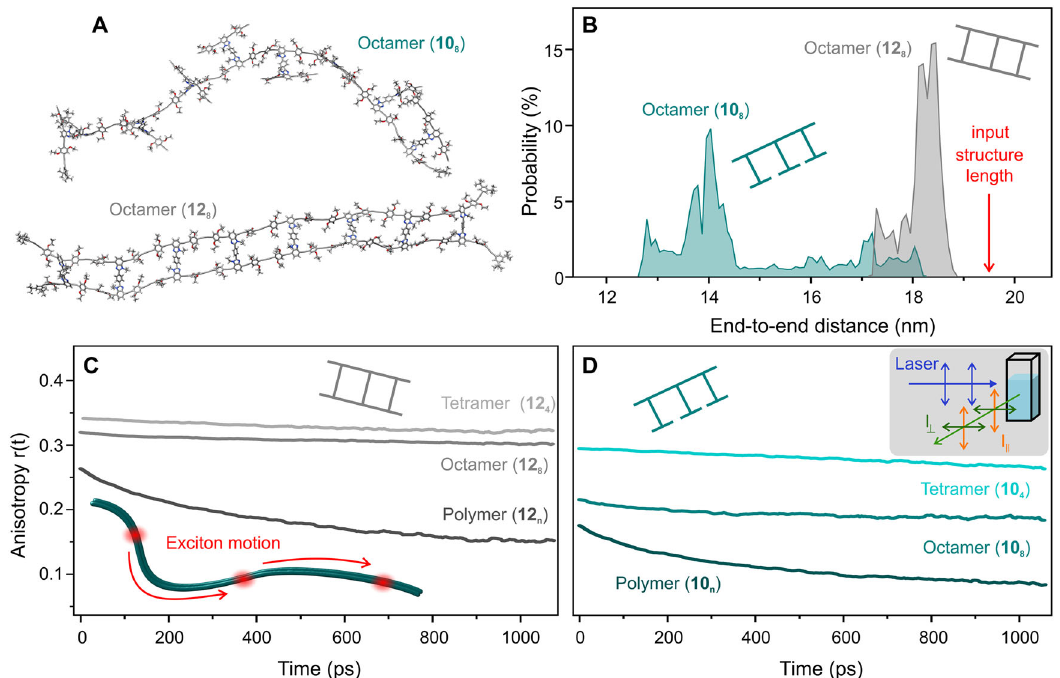
Fig. 2 Shape persistence of π -conjugated ladders. A Representative structures computed from room temperature molecular-dynamics simulations of the open ( 10 8 ) and closed ( 12 8 ) octamer structure. B Radial distribution functions of the end-to-end distances of 10 8 and 12 8 . The open octamer forms mostly bent conformations with an average length of 14.2 nm, whereas the closed structure yields a narrow distribution around 18.2 nm, close to the length of the input structure of 19.5 nm. C and D Transient fl uorescence depolarization in toluene solution at room temperature, demonstrating the high level of rigidity of the ladder structures. Some depolarization arises in the polymers due to exciton motion along slightly curved